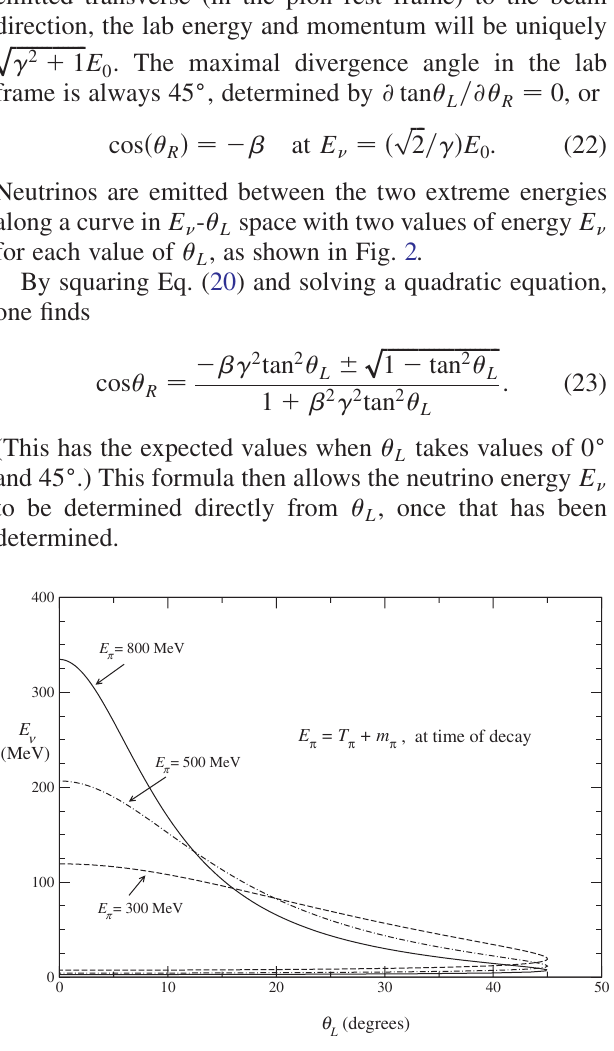
FIG. 2. The neutrino energy, E (in MeV), as a function of (cid:1) from decay in the acceleration section laboratory polar angle (cid:7) L at a given time from bunch injection (or position in the accel- erator) for three pion kinetic energies at the time of decay. Each pion energy corresponds to a specific location for the decay in for the accelerator section. There is a twofold degeneracy of E (cid:1) , except at the maximum neutrino angle in the each value of (cid:7) L lab frame, 45 (cid:4) , which occurs at a low neutrino energy.